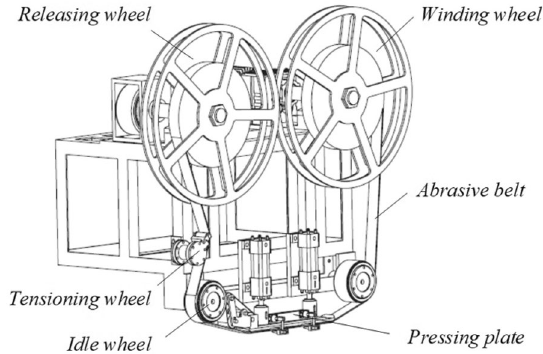
Figure 1 Principle of rail grinding with open-structured abrasive belt based on pressing